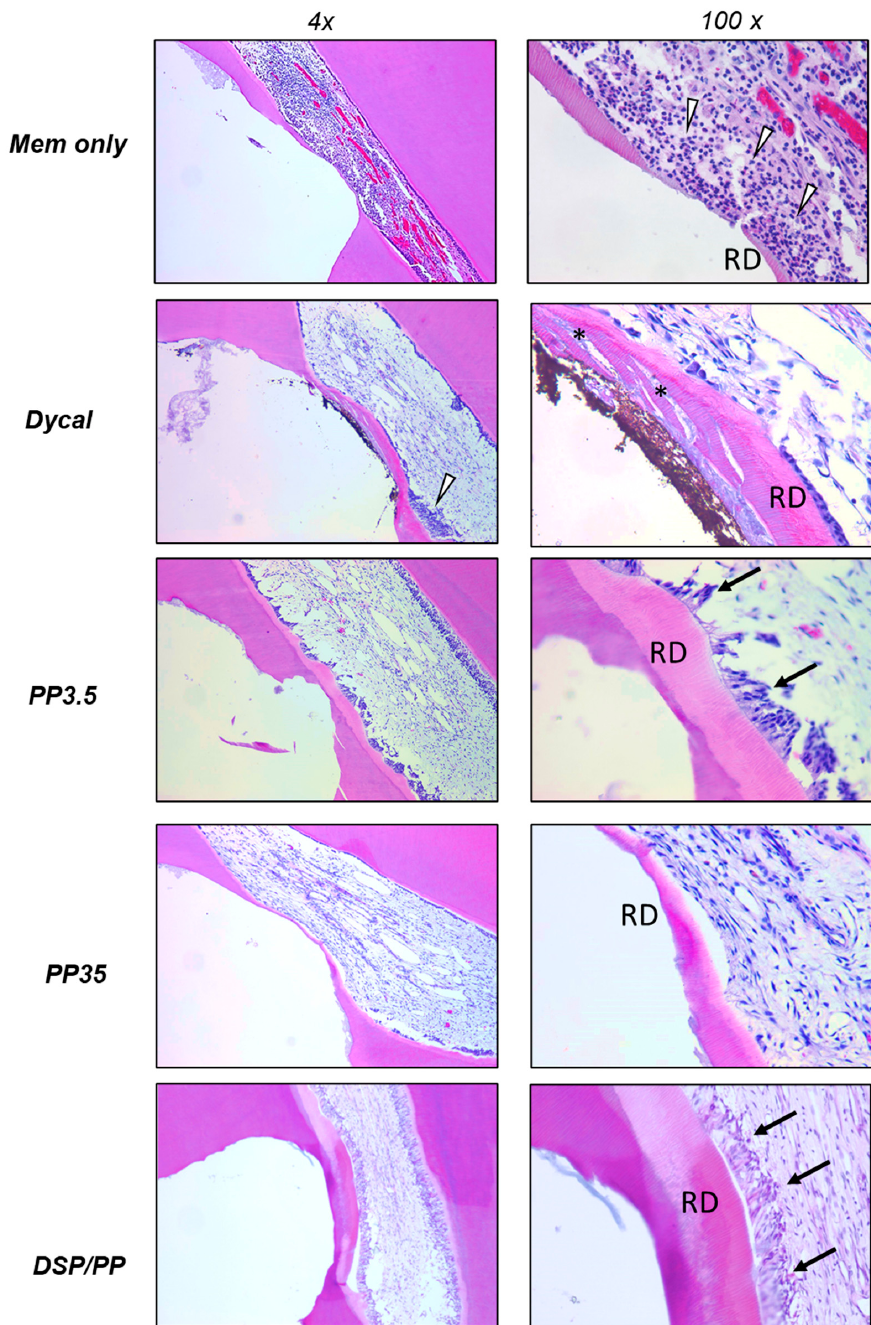
Figure 6 . Histological findings of ferret teeth after direct pulp capping. Group Col showed pulp inflammation with infiltration of inflammatory cells (indicated by hollow arrowheads) and vessel congestion. The reparative dentin (RD) was thin and incomplete. Group Dycal also showed the presence of inflammatory cells. The reparative dentin was thick but contained tunnel defects (indicated by asterisks). Group PP3.5 presented reparative dentin with tubular structures and adjacent odontoblast lining (black arrows). In Group PP35, the reparative dentin was complete but thin. The odontoblast layer was absent. Group DSP/PP showed intact reparative dentin and odontoblast lining. Photos of left and right columns were at 4 × and 100 × magnification,